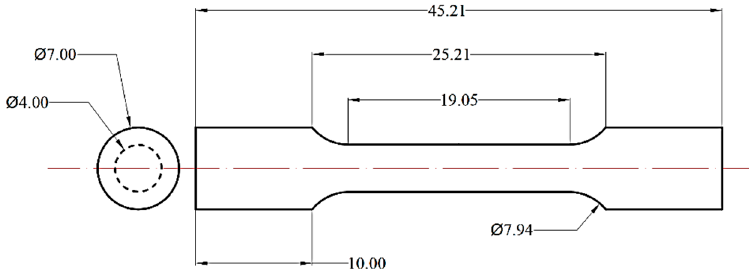
Figure 4. Geometry of tensile samples (unit: mm).